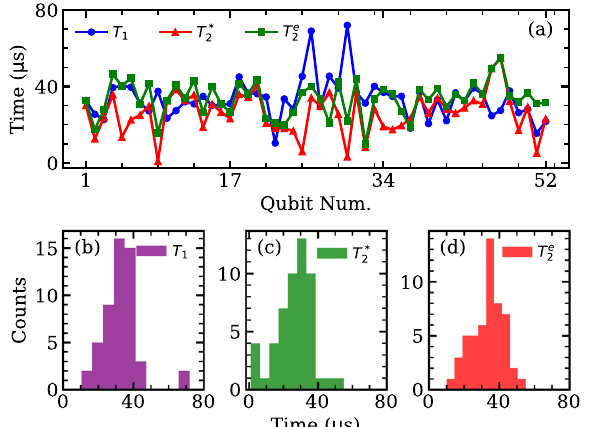
Fig. 5 T 1 , T 2 *, and T 2e of each qubit of a multi-qubit chip with Ta fi lm. a T 2e (green) characterization results of a 1 (blue), T 2 * (red), and T 56-qubits chip fabricated with the same processes described here. ( b − d ) are histograms of the T 1 , T 2 *, and T 2e of all the qubits in the chip, respectively.